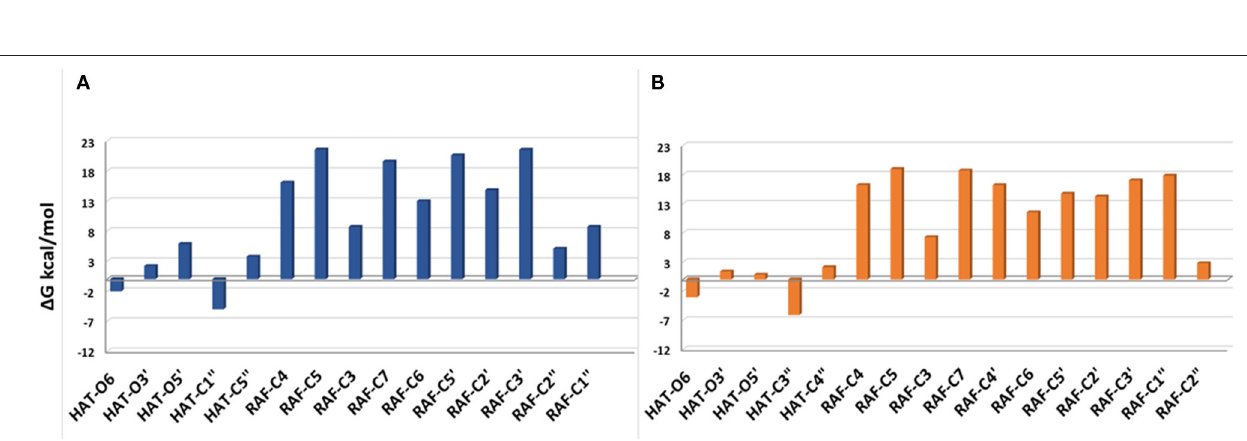
FIGURE 2 | Relative Gibbs free energies ( 1 G kcal/mol) values at 298.15K for neutral moracin C (H 3 A), monoanion (H 2 A − ), neutral iso -moracin C (H 3 B), and monoanionic (H